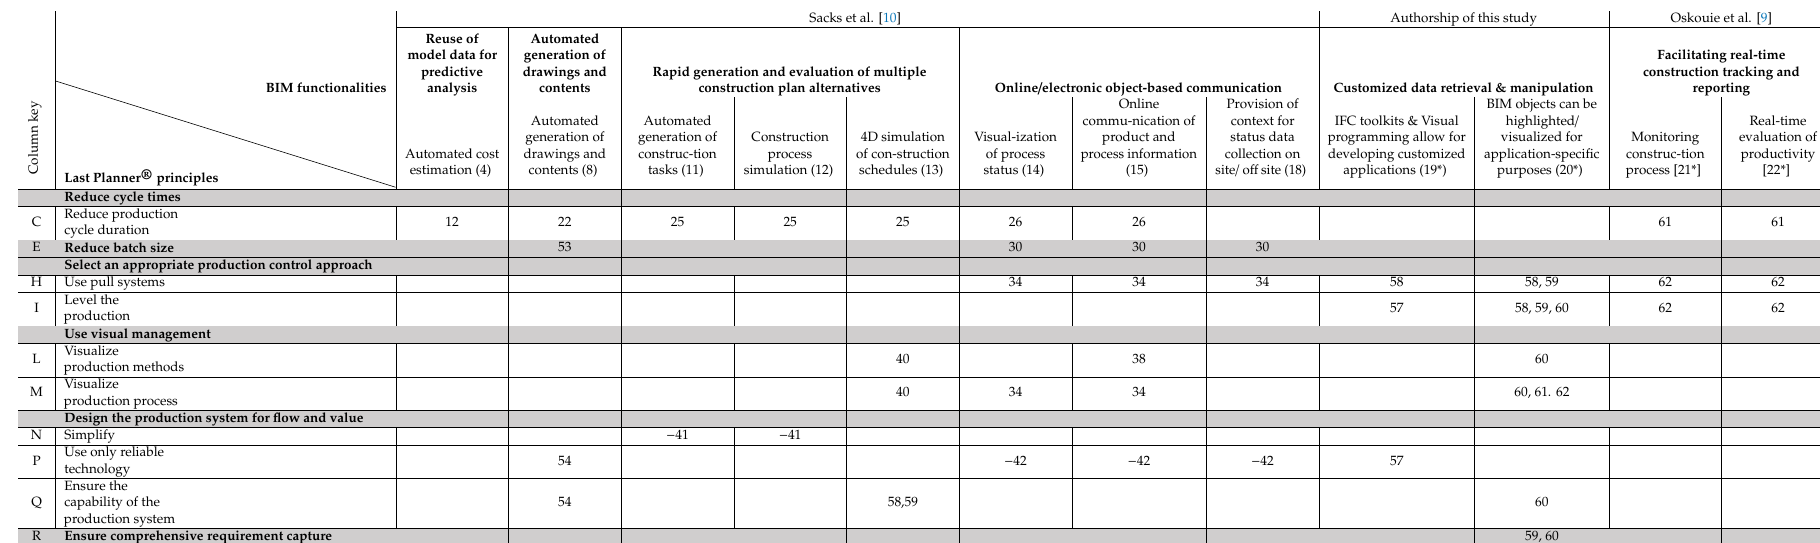
Table 1. New BIM-LPS interaction